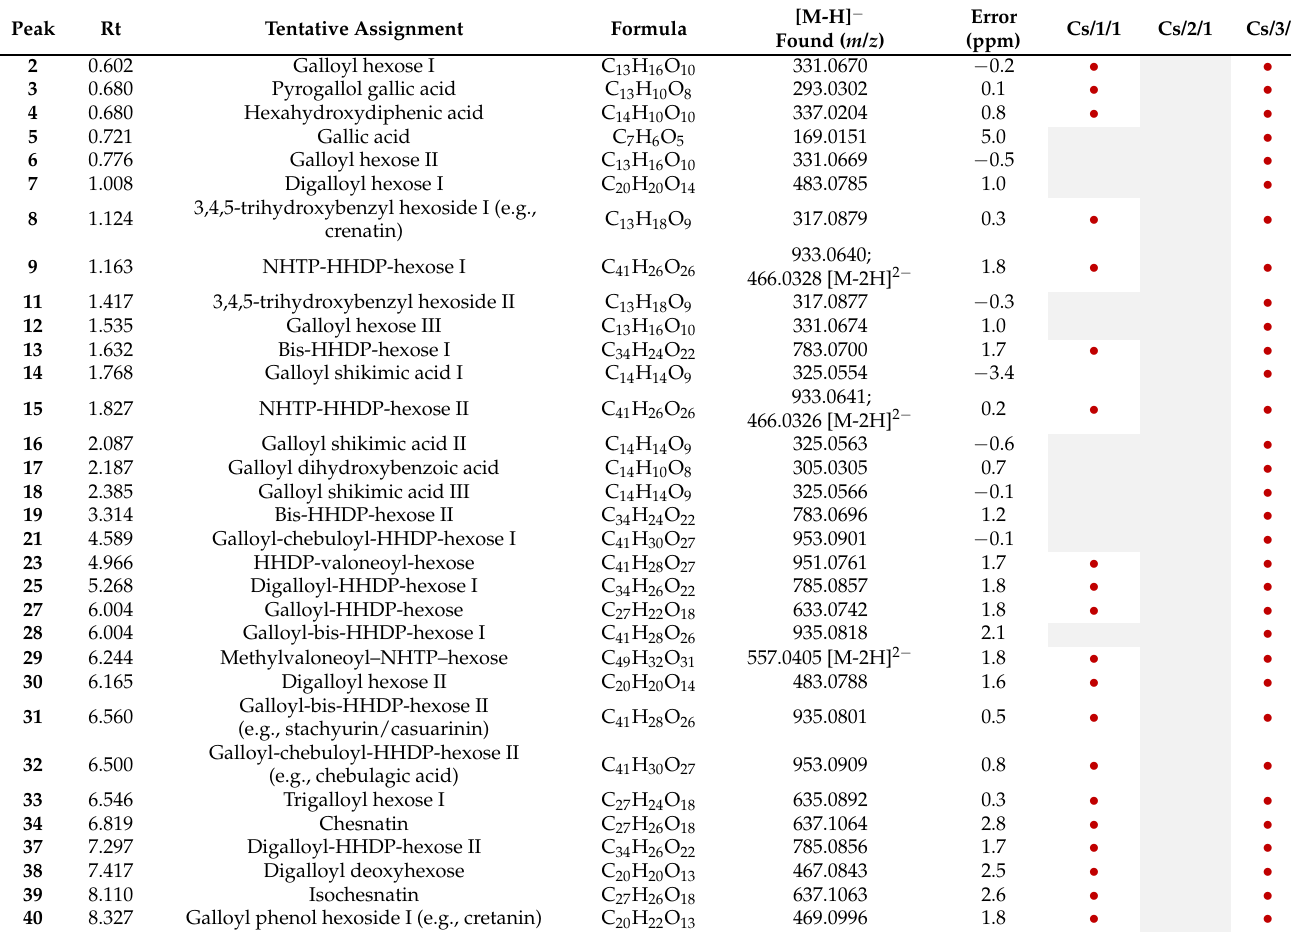
Table 2. Gallo- and ellagitannin compounds (and their metabolic precursors) tentatively identified in the chestnut Cs/1/1 alcoholic extract and its fractions. Rt = retention time. Base peak fragments are reported in bold. • Detected (Grey color box = not